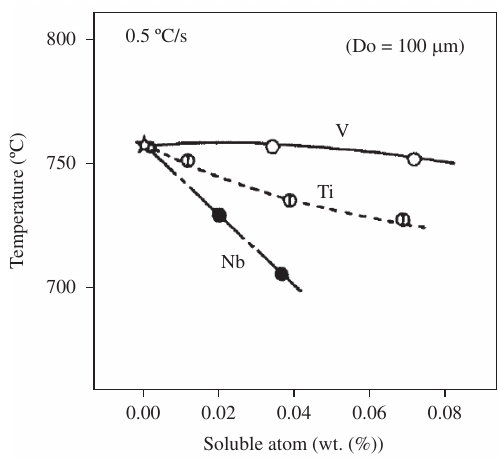
Figure 1. The effect of niobium and titanium in solution on the transformation start temperature